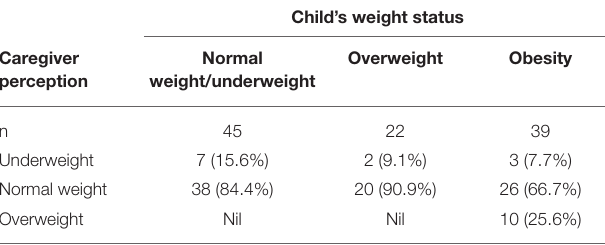
TABLE 2 | Caregiver perceived vs. actual weight status of the child ( n =